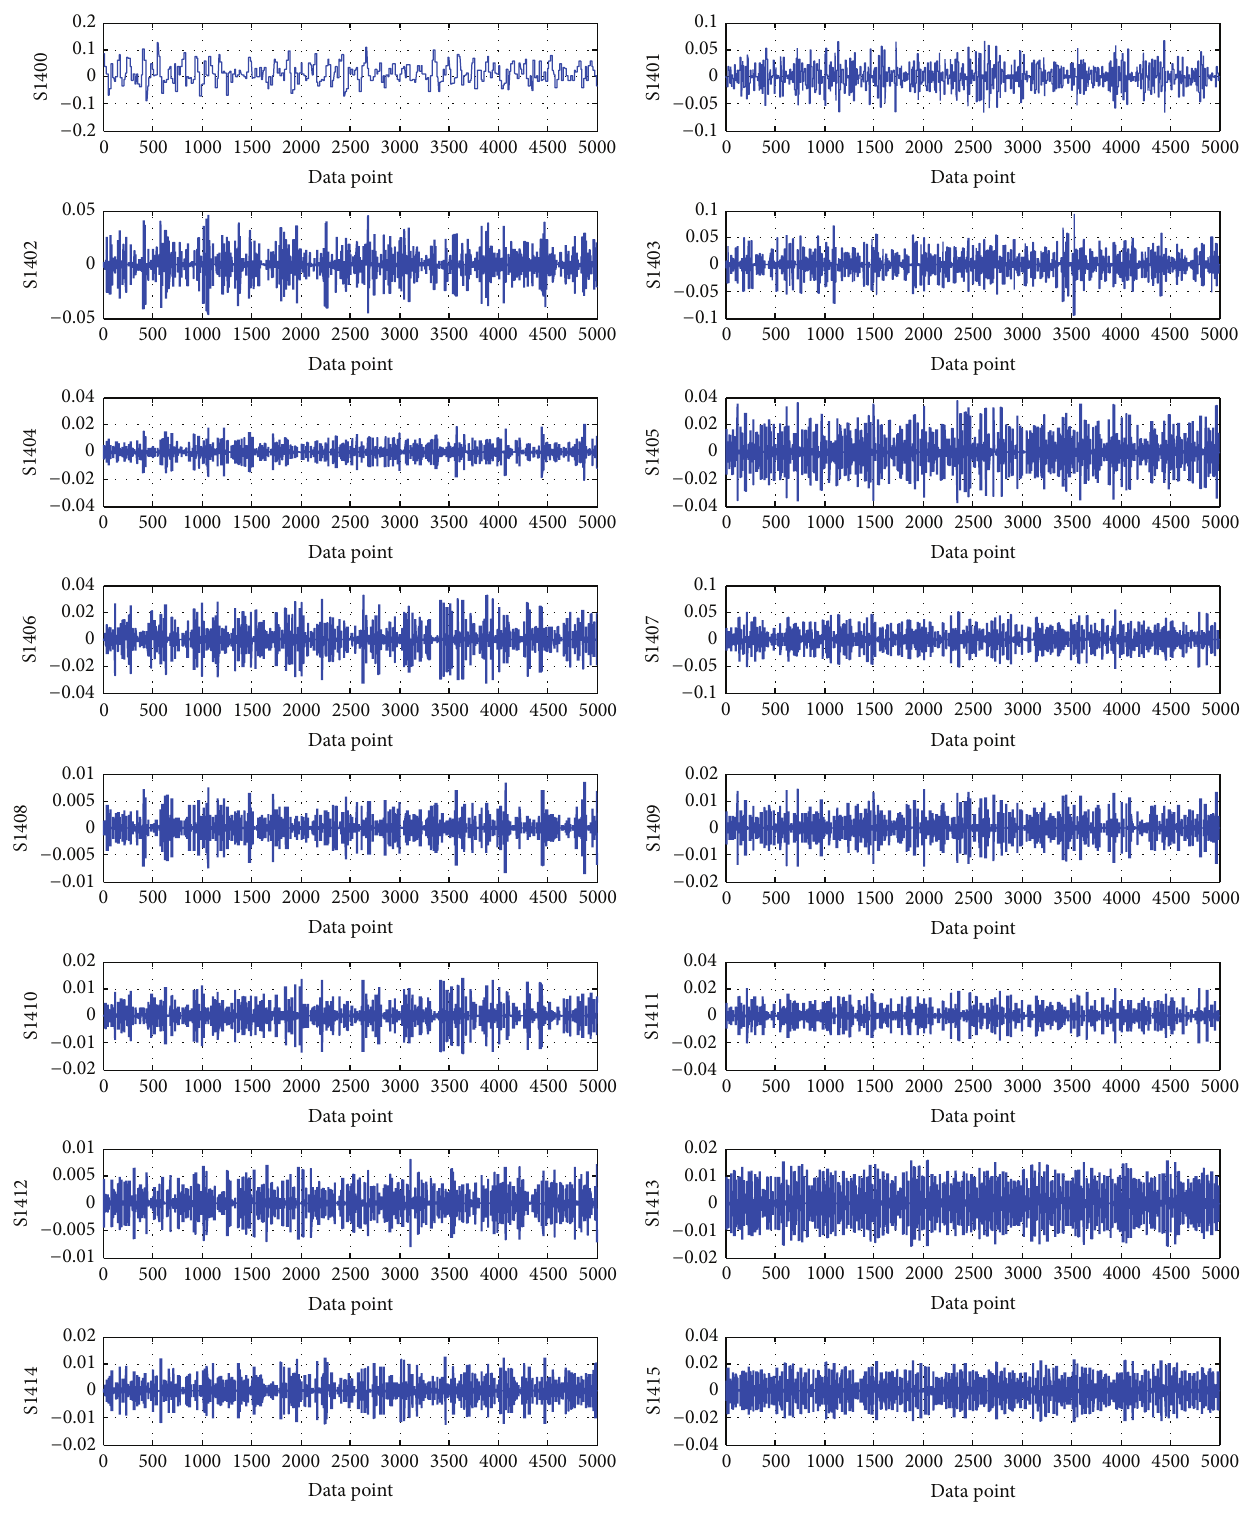
Figure 2: 16 wavelet coefficients of one of the samples representing normal